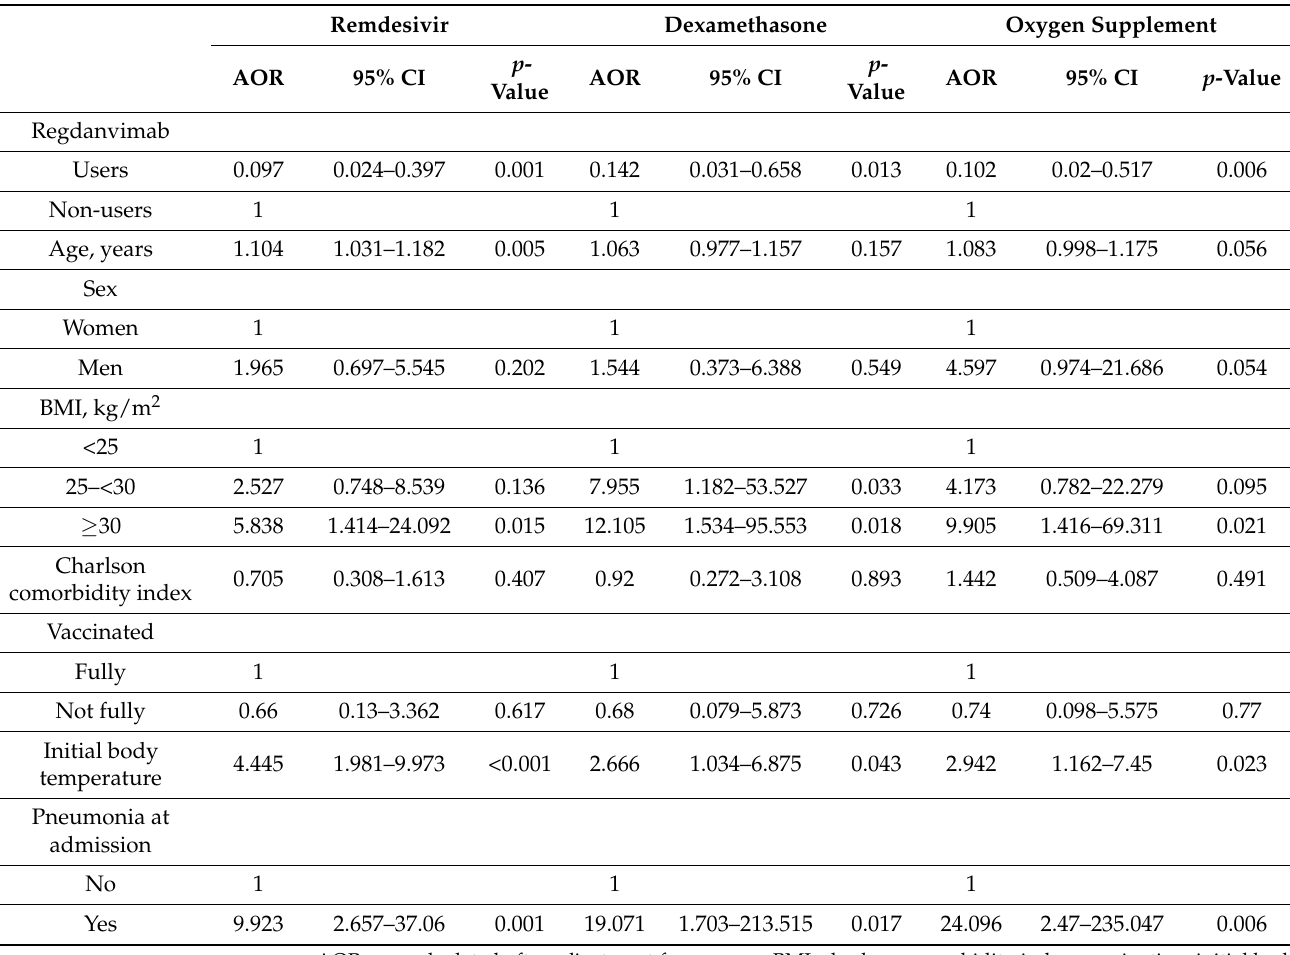
Table 2. Impact of regdanvimab use on the initiation of remdesivir, dexamethasone, and oxygen in patients with mild-to-moderate COVID-19.